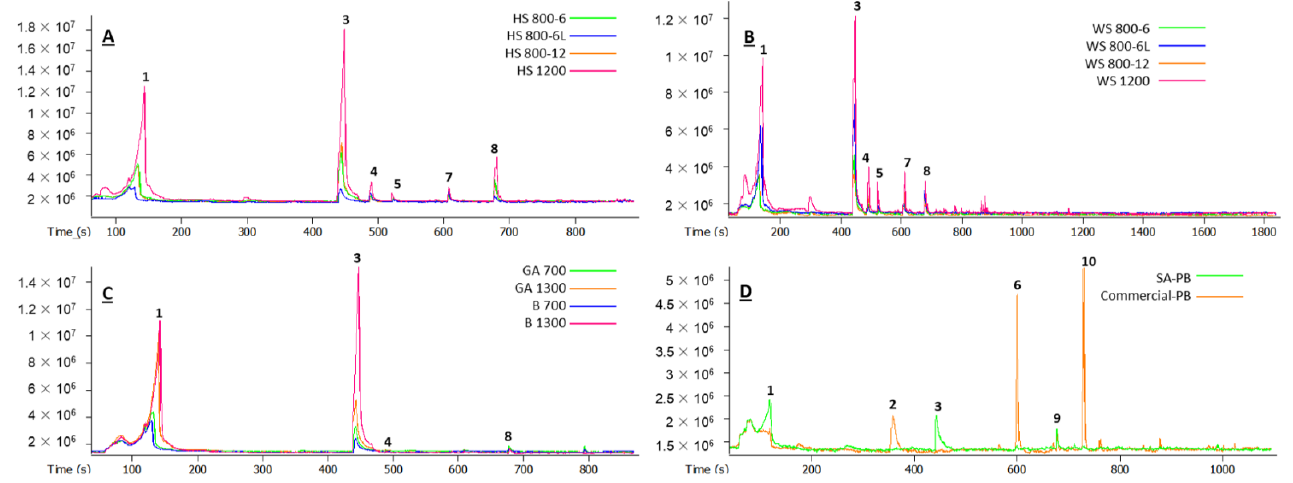
Figure 2. The GC–MS chromatograms (TIC—total ion current) of the VOCs from different board samples: 1—acetic acid; 2—hexanal; 3—furfural; 4—2-furanmethanol; 5—1,3-propanediol; 6— α -pinene; 7— γ -butyrolactone; 8—5-methylfurfural; 9—sylvestrene; 10—nonanal.